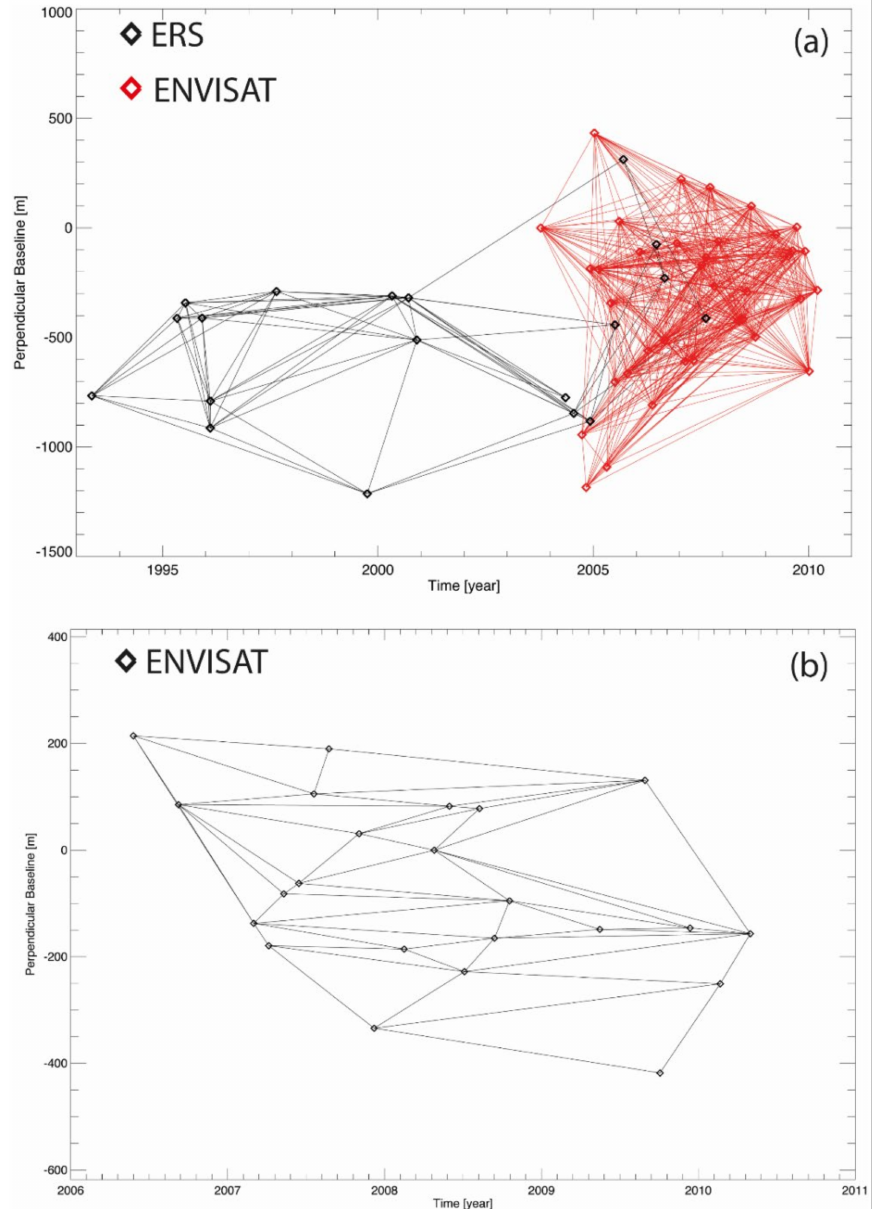
Figure 1. Examples of SB InSAR data pair distributions in the temporal/perpendicular baseline domain. ( a ) SAR data collected by the ERS/ENVISAT sensors in Yellowstone, U.S. (track 41, frame 2709) region. The applied thresholds on the maximum geometrical and temporal baselines are 800 m and three years, respectively. ( b ) A triangular-shaped network of SB interferograms related to a SAR data set collected by the ENVISAT sensor (ascending orbit, VV polarization) in the area of Pearl River Delta, China, from 2006 to